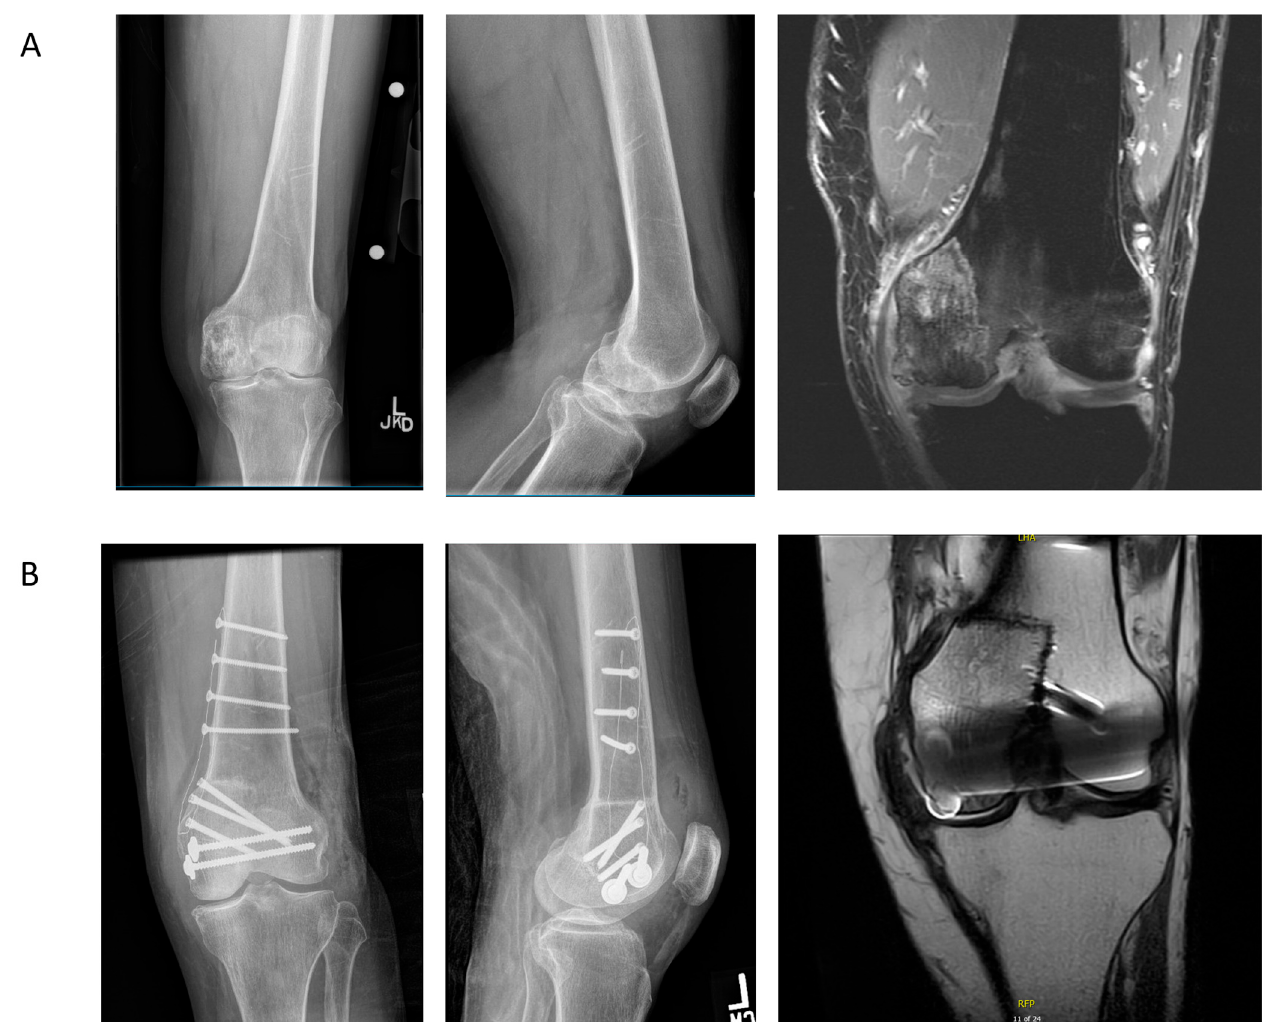
Figure 3. ( A ) Pre-operative anteroposterior (AP) and lateral radiographs of the distal femur and T1-post-contrast fat-saturation coronal magnetic resonance (MR) image of the knee, demonstrating a grade 2 chondrosarcoma of the medial femoral condyle. ( B ) The 12-month post-operative AP and lateral radiographs and proton density coronal MR image of the knee, demonstrating interval hemicondylar resection and osteoarticular allograft reconstruction with a carbon fiber plate and sup- plemental screw fixation. Minimal susceptibility artifact from the plate is noted with comparatively higher artifact from the metallic